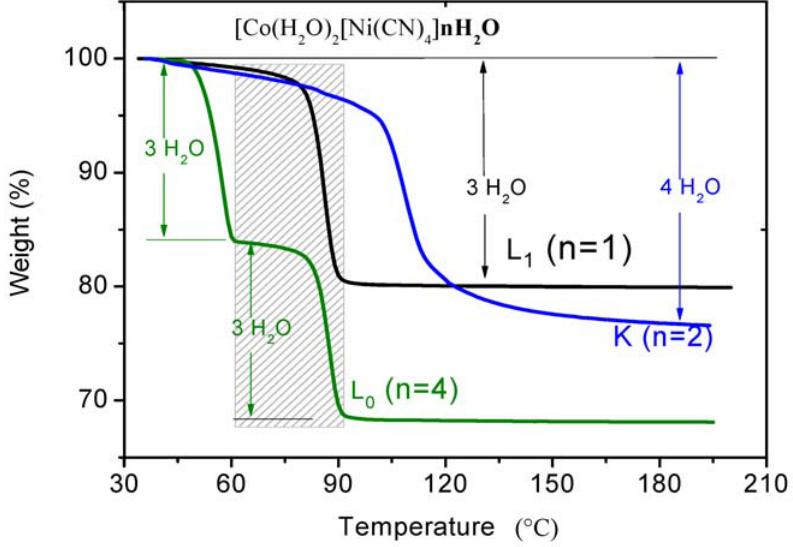
Figure 3. Thermogravimetric curves (TGs) for Co(H K and L phases). The framed area emphasizes the similarity between the dehydration of 0 sample (second step) and the L the L 1